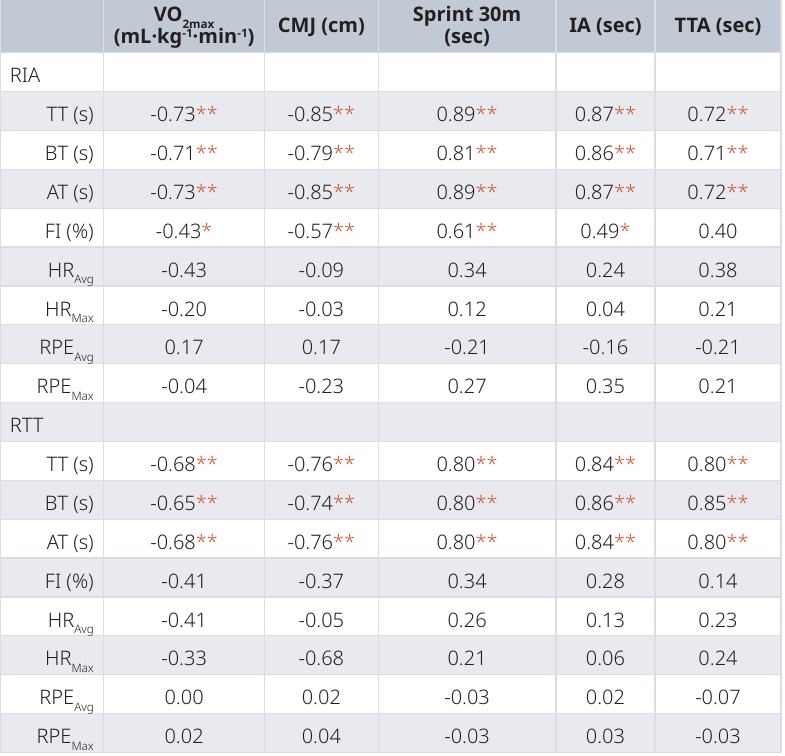
CMJ = countermovement jump; TT= total time; BT = best time; AT = average time; FI = fatigue index ; Sprint 30m = 30 metre sprint; IA = Illinois Agility test; TTA = T-test agility; VO = maximal 2max aerobic capacity , RPE = Average Rate of Perceived Exertion, RPE = Maximum Rate of Perceived Avg Max Exertion, HR = Heart rate average, HR = Maximum heart rate *P<0.05 **P<0.01 ***P<0.001 Avg Max